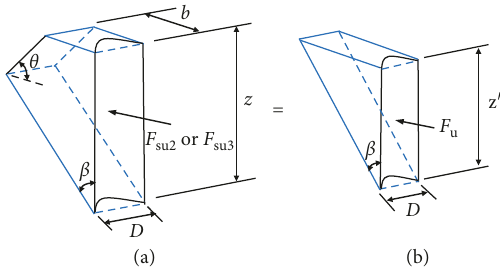
Figure 4: (a) The failure wedge modeled near the slope and (b) the equivalent failure wedge in horizontal